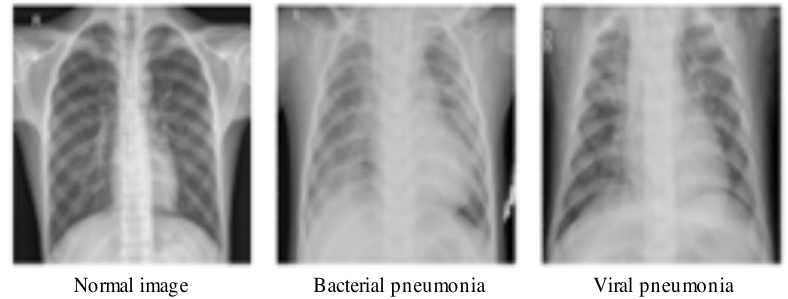
Figure 4. Illustrative samples of chest-xray-pneumonia from the dataset in